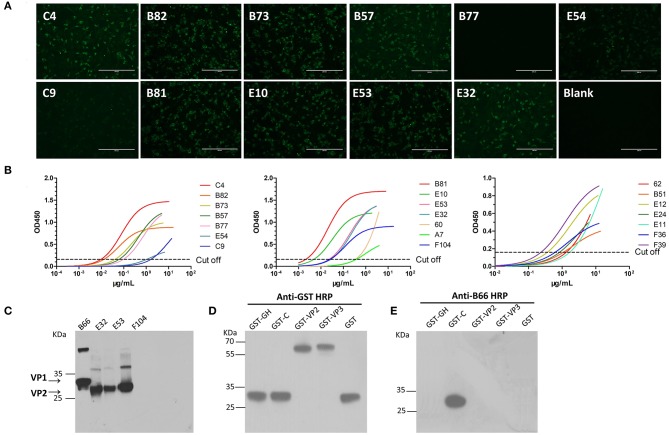
Characterization of FMDV-specific mAbs. The reactivity of cattle mAbs were checked by IFA, indirect ELISA and WB. The IFA (A) was performed using BHK cells infected with the O/Mya/98 strain, and the working concentration of the tested cattle mAbs was 5 μg/ml, followed by incubation with goat anti-cattle FITC (diluted 1:5,000 in PBS). The indirect ELISA (B) were carried out by incubation with different concentrations of 0–20 μg/ml of the tested mAbs with FMDV 146S antigen, followed by probing with anti-His HRP (diluted 1:6,000 in PBS). The lysis of 146S antigen (C) and GST-fused antigens (D) of FMDV were subjected to 12% SDS-PAGE and electrophoretically transferred to a nitrocellulose membrane. The membrane was incubated with tested mAbs and then probed with a 1:5,000 dilution of HRP-conjugated goat anti-cattle IgG (Sigma-Aldrich, USA). (E) B66 stained with GST-C antigen and showed the binding with VP1 C-termial of FMDV.